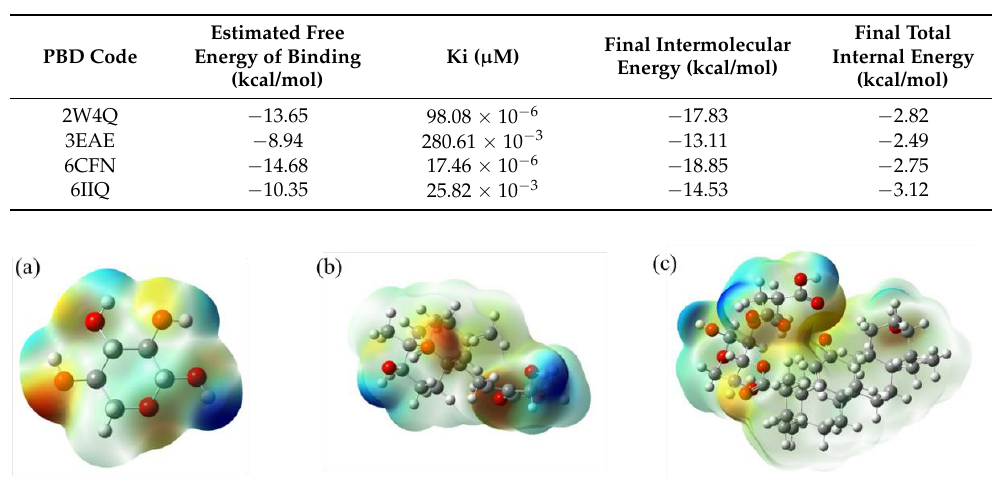
Table 2. The dock evaluation of receptor protein with GA-BX/AD-g-IA.